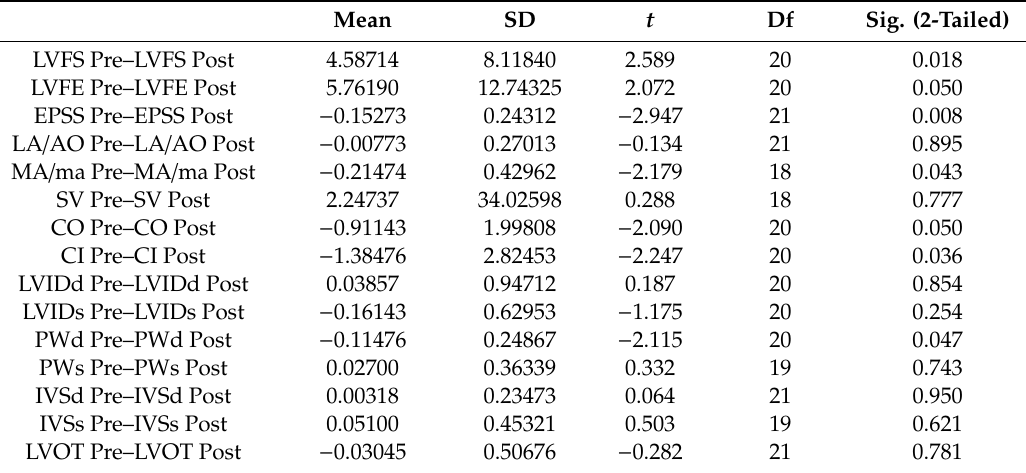
Table 9. Paired t -test comparison between pre- and post-exercise echocardiographic